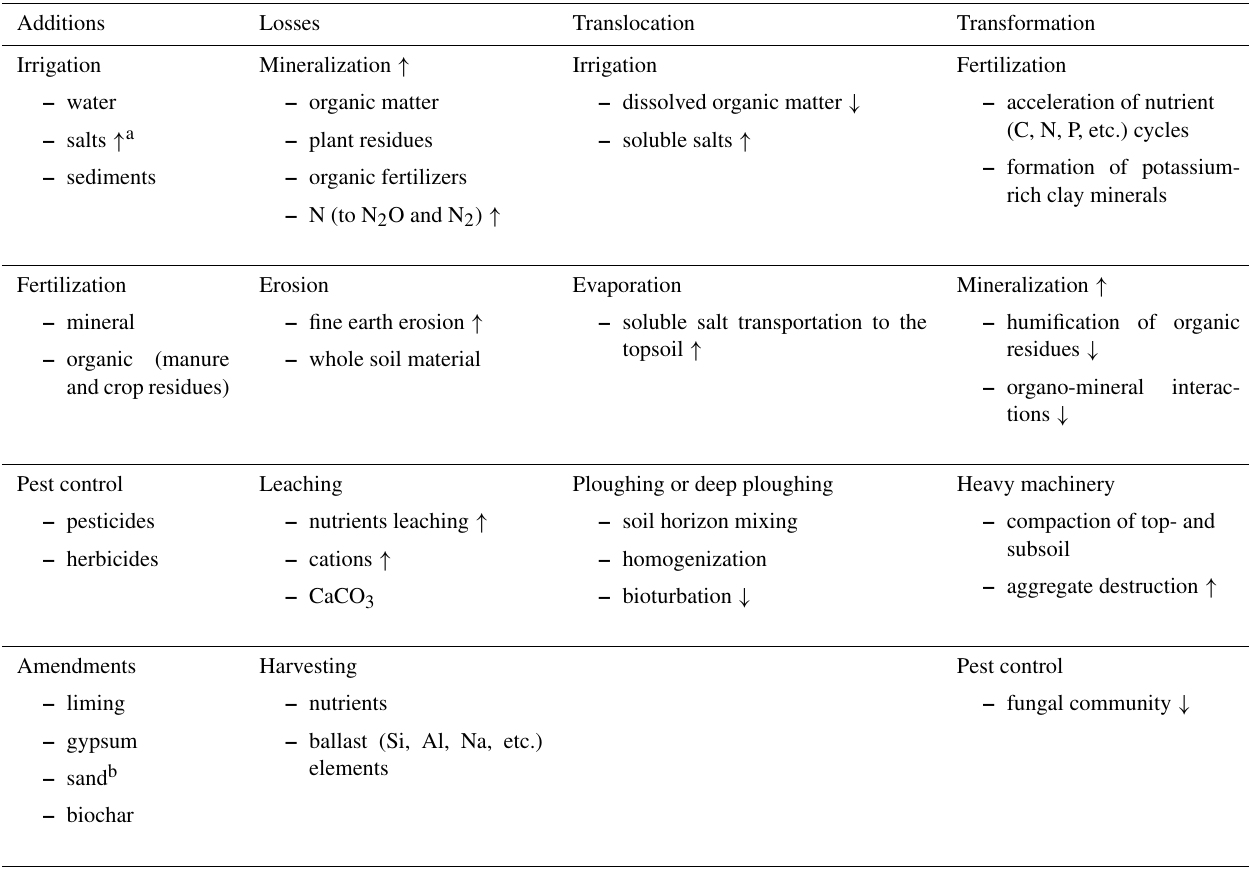
Table 2. Soil formation processes under agricultural